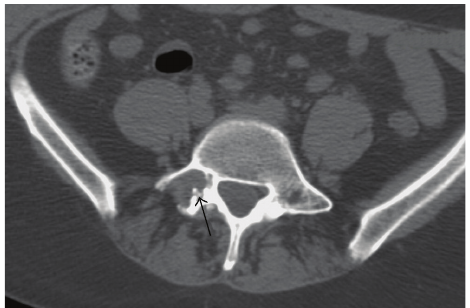
Figure 1: CT image shows a well-circumscribed, minimally expansile lytic lesion in the right pedicle and adjacent transverse process of L5. Tiny densities (arrow) represented bony fragments from adjacent degenerated facet joint.